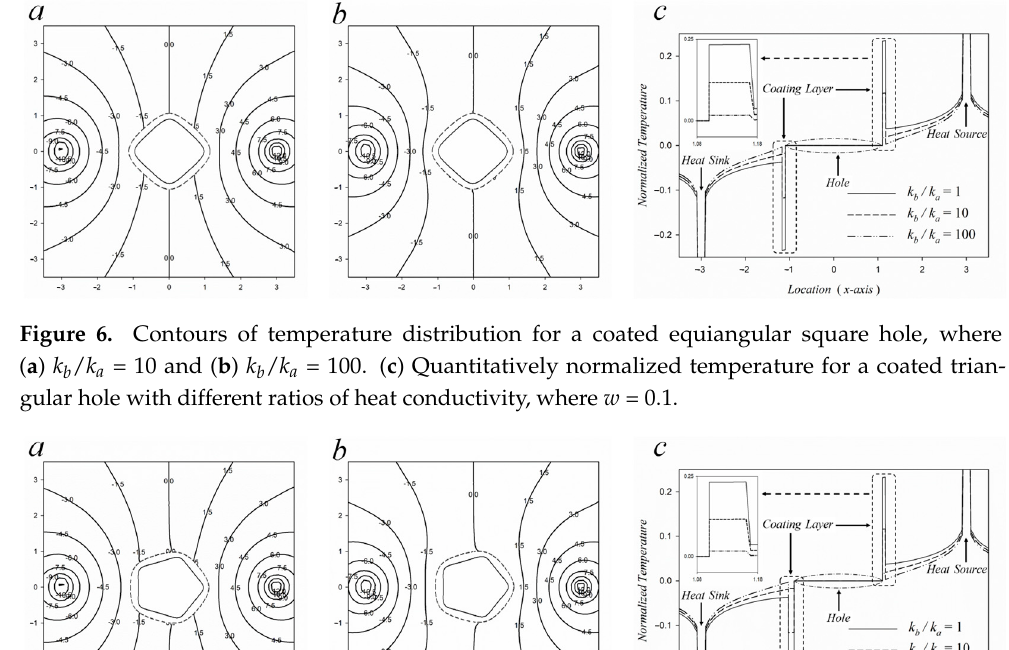
Figure 5. Contours of temperature distribution for a coated equiangular triangle hole, where ( a ) k b /k a = 10 and ( b ) k b /k a = 100. ( c ) Quantitatively normalized temperature for a coated triangular hole with different ratios of heat conductivity, where w = 0.1.